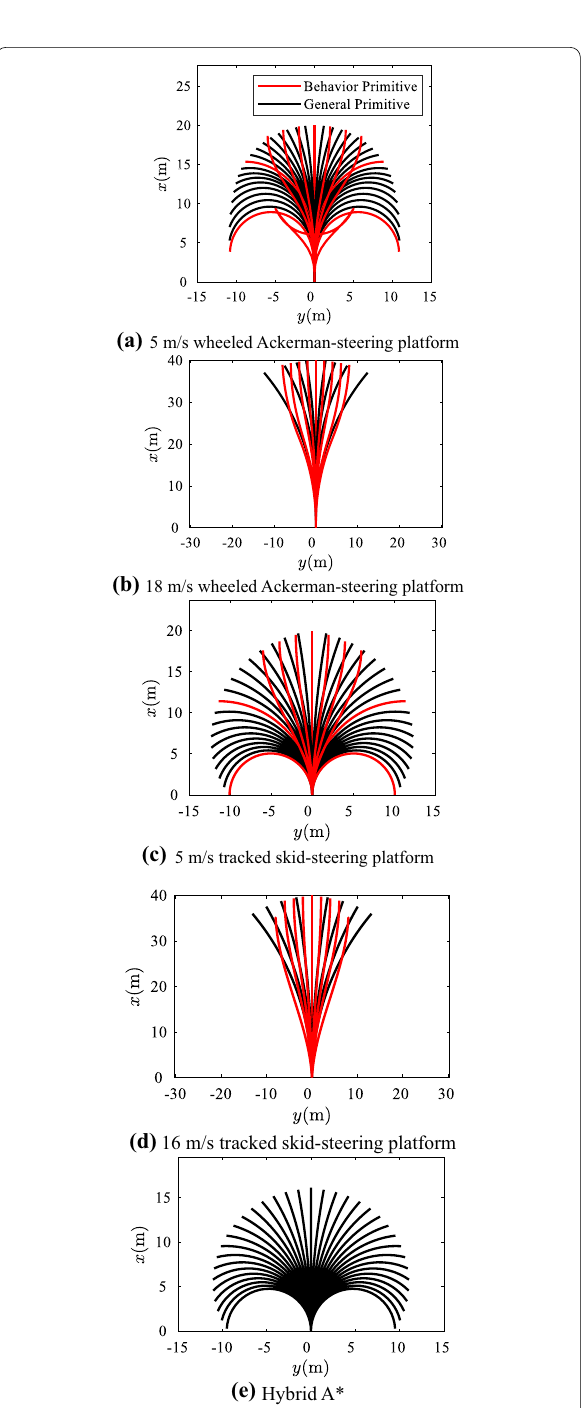
Figure 10 Comparison of MP cluster generation